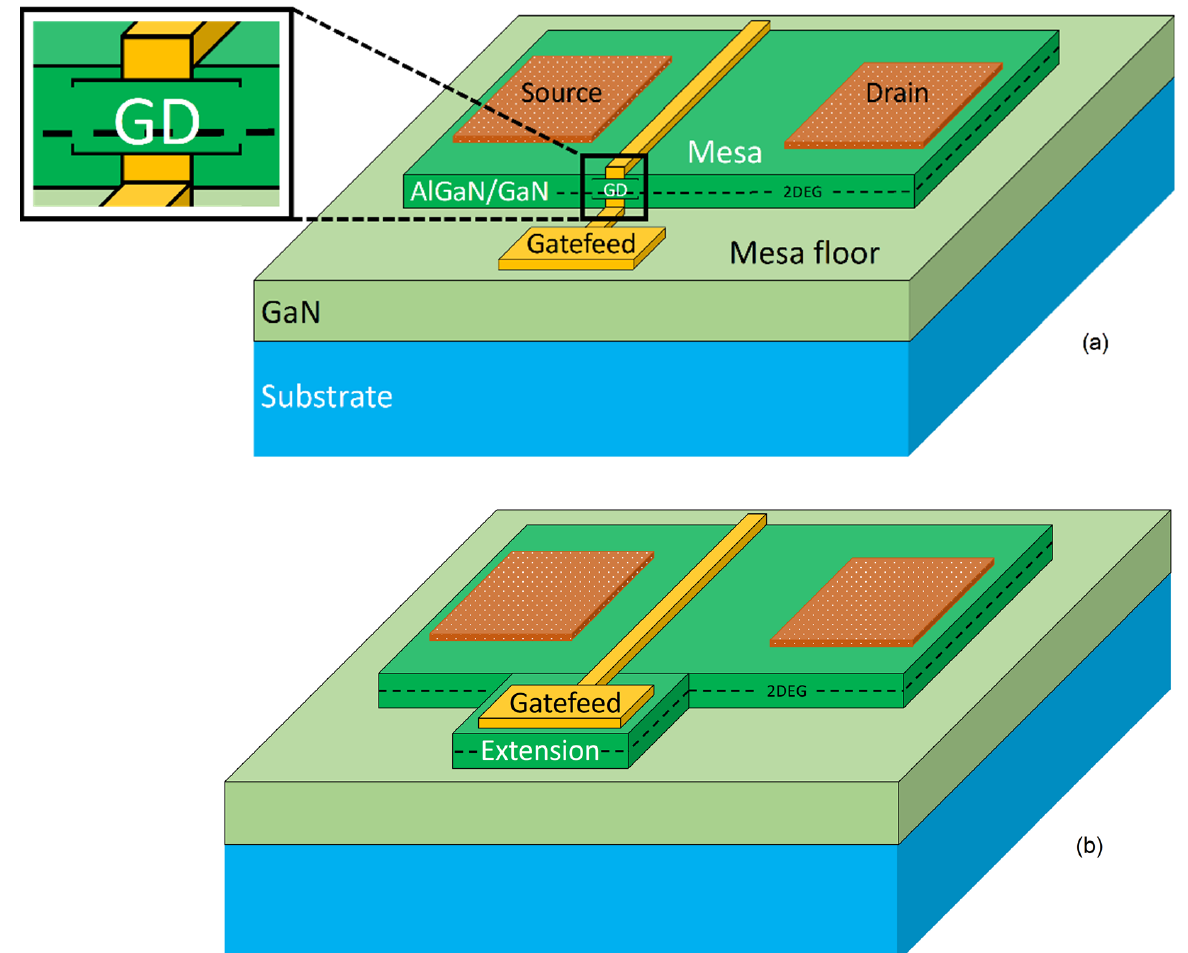
Figure 1. Conventional gallium nitride (GaN)-based high electron mobility transistor (HEMT) device with its gatefeed on mesa floor (fin-like gate) with the common issue of gate discontinuity (GD) shown at the mesa edge ( a ), and the proposed design of mesa extension for gatefeed ( b ).